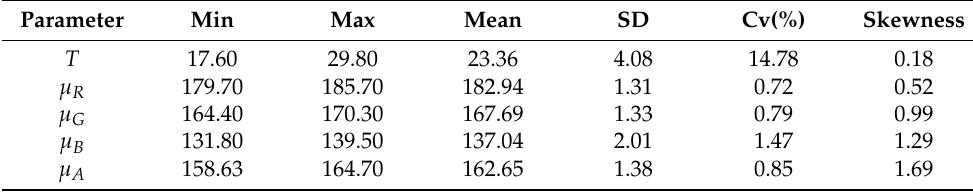
Table 3. Characteristic parameters at different temperatures.